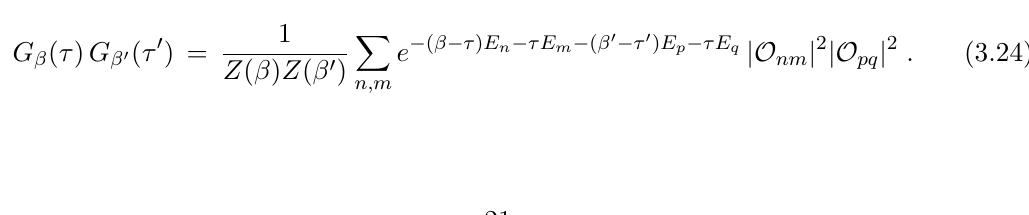
≥ 2 π , and d β 0 / d m > 0 HP HP